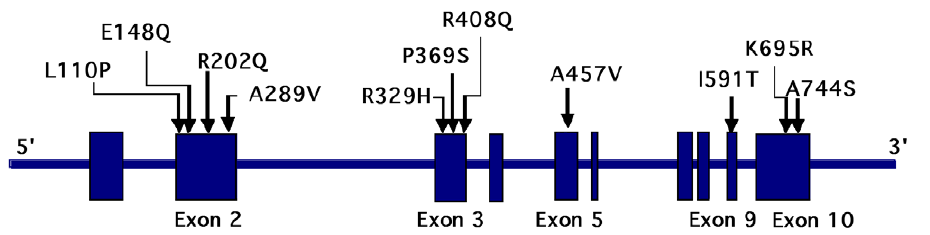
Figure 1. Missense mutation detected in the MEFV gene in FMS patients. Part of the genomic organization of the MEFV gene and a map of the missense mutations in patients with Fibromyalgia Syndrome are